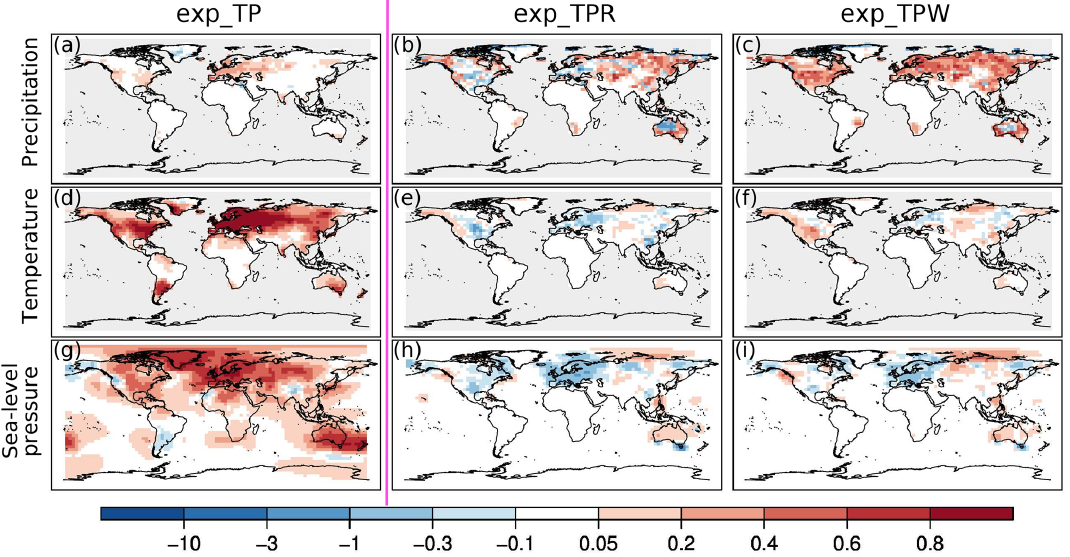
Figure 6. Summer season RMSESS values of exp_TP (a, d, g) , exp_TPR (b, e, h) , and exp_TPW (c, f, i) . x f is the ensemble mean of the CCC400 model simulations when the RMSESS values are calculated for the exp_TP experiment, while x f was replaced with the analysis mean of exp_TP for the other two